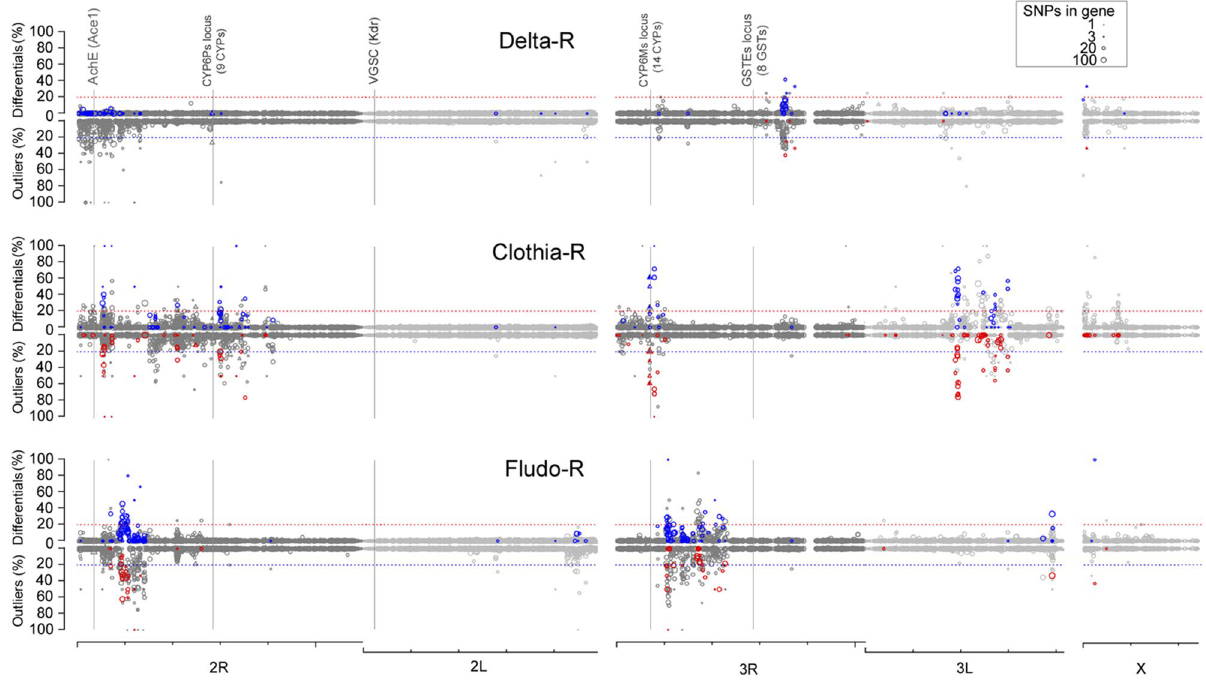
Figure 5. Selection signatures observed in each selected line. Selection signatures as compared to the non- selected Tiassalé-S line were computed using the 145,008 bi-allelic polymorphic SNPs detected by RNA-seq. The upper Y axis shows the proportion of differential SNPs per gene as obtained by the frequency-based approach while the lower Y axis shows the proportion of outliers per gene as obtained by the Fst-based approach. For each approach, blue/red marks indicate genes showing a differential/outlier proportion higher than 20% with the alternative approach (red/blue dashed lines). Symbol size is proportional to the number of polymorphic SNPs per gene. Triangles indicate candidate genes potentially involved in insecticide resistance. Filled symbols indicate the presence of differential SNPs/outliers affecting protein sequence. Loci commonly associated with insecticide resistance in An. gambiae are indicated (VGSC, AchE, CYP6Ps cluster, CYP6Ms cluster and GSTEs cluster). The genomic scale shows chromosome arms with ticks every 10